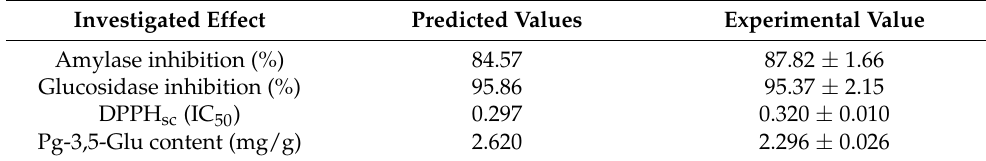
Table 3. Predicted and experimental